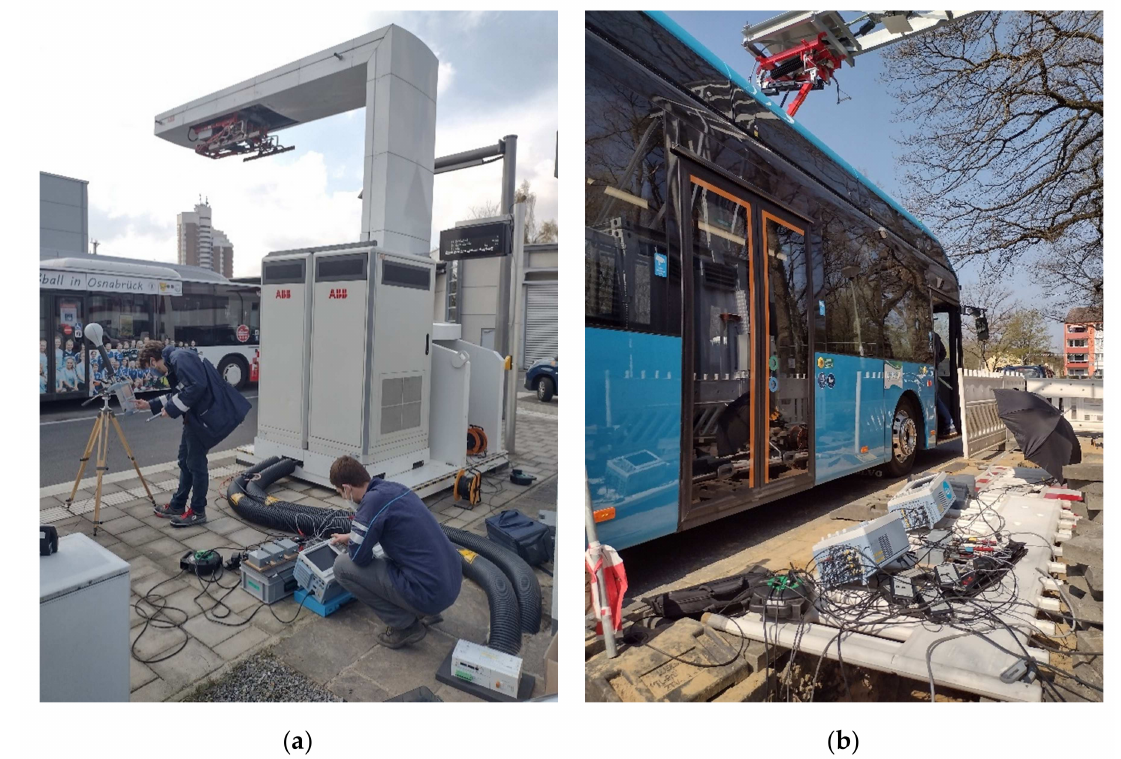
Figure 3. Measurement’s setup. ( a ) Setup 1; and ( b ) setup 2.